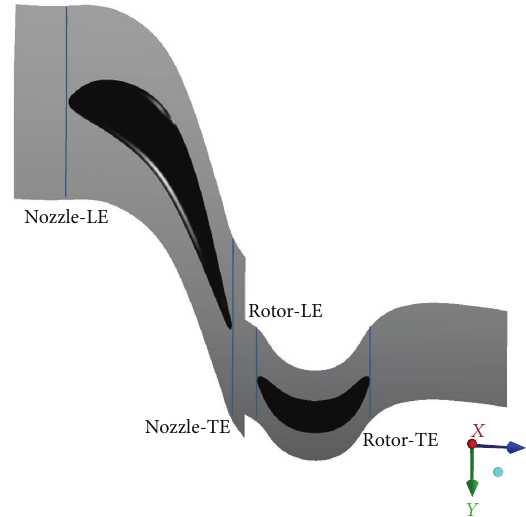
Figure 6: Profiles where temperatures were extracted.